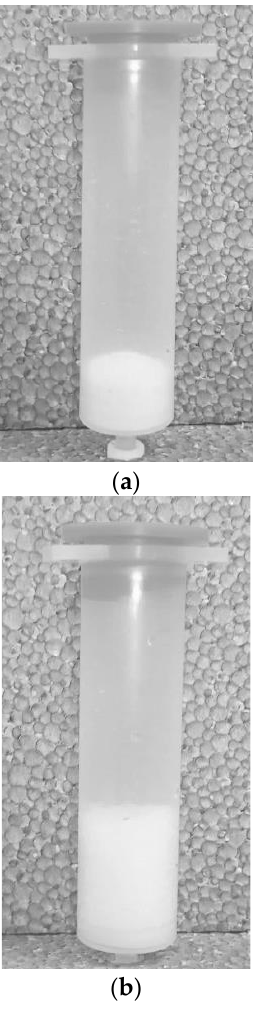
Figure 1. Amino-Li-resin weighed ( a ) Before swelling ( b ) After